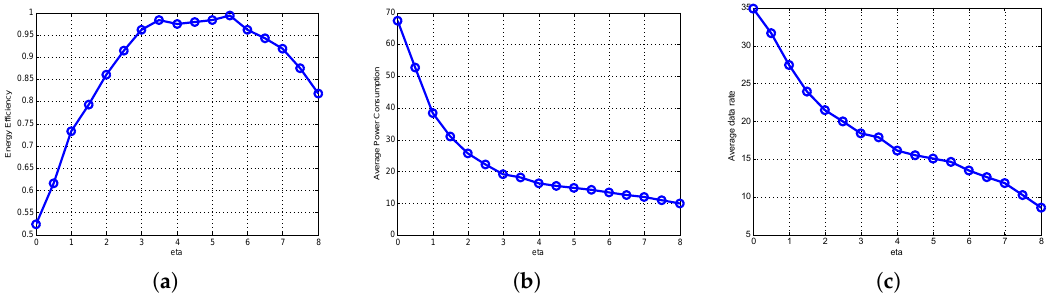
Figure 6. The average energy efficiency, power consumption and throughput with different values of η . ( a ) Average energy efficiency; ( b ) average power consumption; ( c ) average data